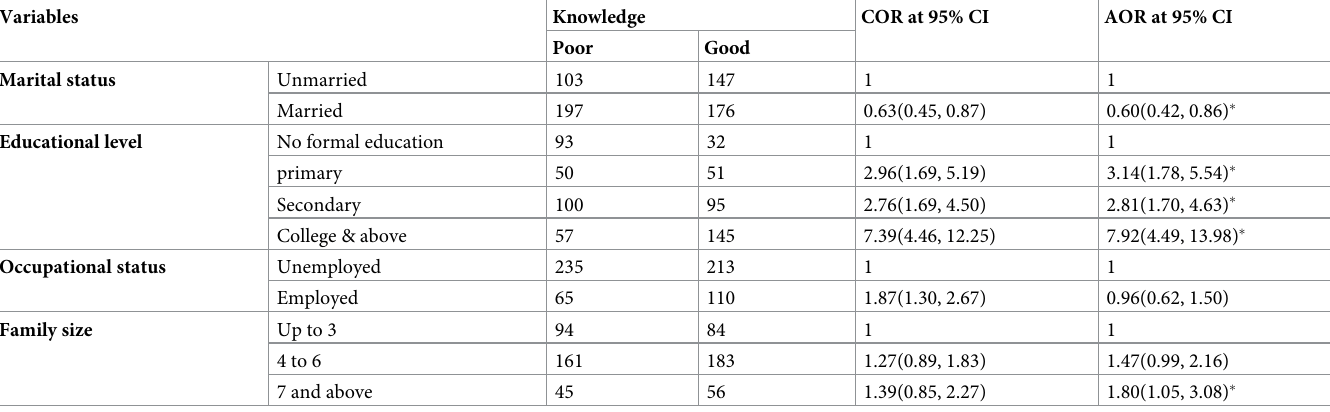
Table 4. Factors associated with knowledge of communities about COVID-19 in Gondar city, northwest Ethiopia, 2020.